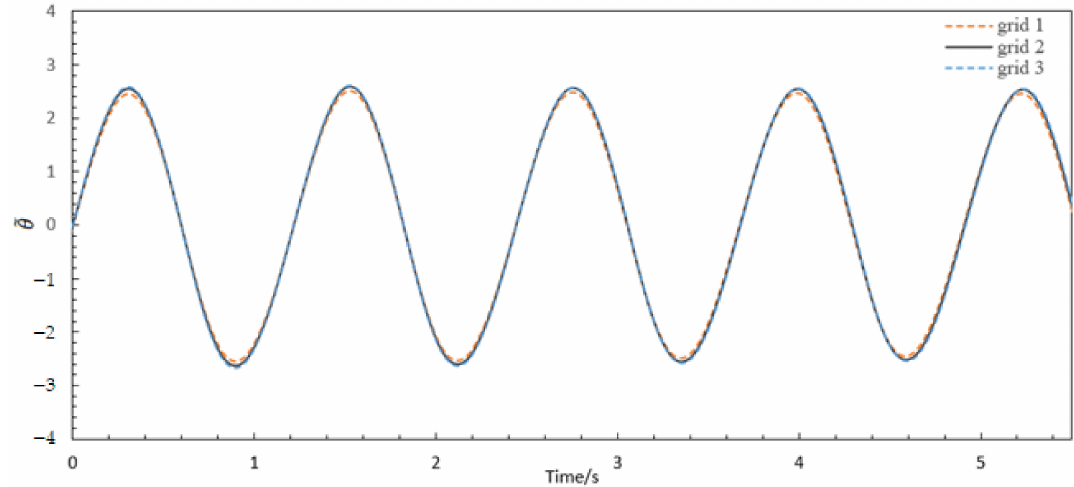
Figure 9. Time histories of (cid:101) θ of the ship obtained on grids 1, 2 and 3.